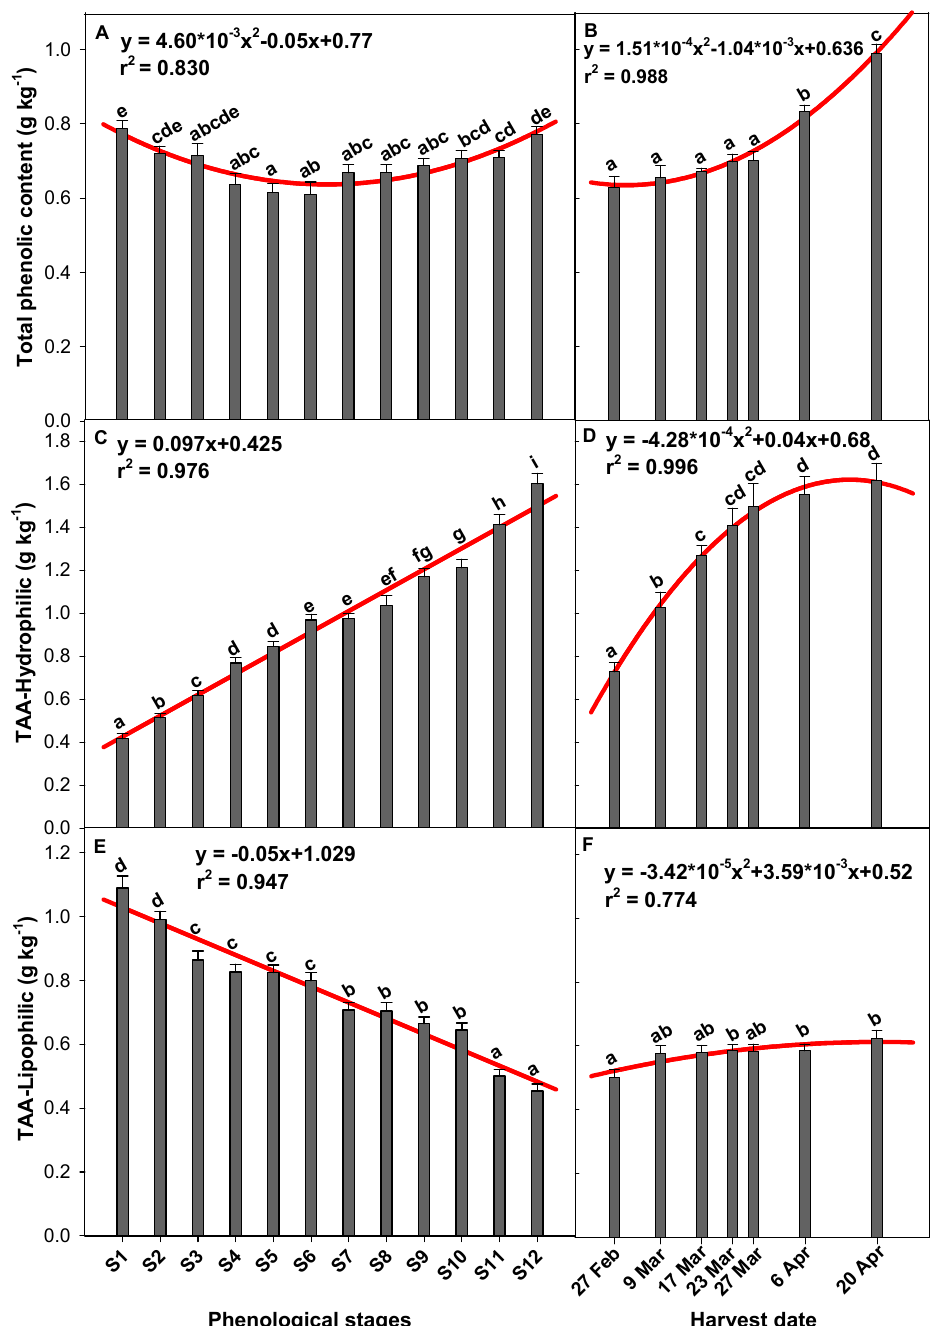
Figure 2. Influence of phenological stages ( A , C , D ) and harvest date ( B , D , F ) on total phenolic content ( A , B ), and the TAA-Hydrophilic ( C , D ) and Lipophilic ( E , F ) (g kg − 1 ) levels of green pepper fruit. Lowercase letters show significant differences ( p < 0.05) among phenological stages or harvest dates. A quadratic model regression and its coefficients are shown in each graph.